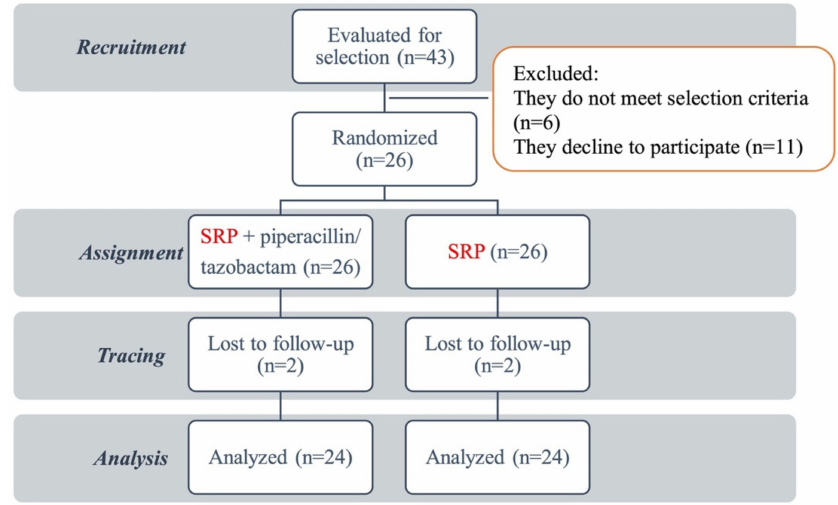
Figure 4. Participant flowchart.